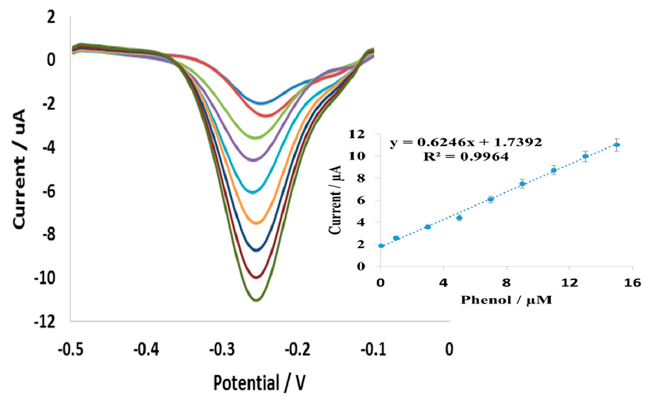
Figure 7. DPV obtained with the SPCE/Gr-Au-Chit/Tyr in 0.1 M PBS (pH 7.0) containing different concentrations of phenol from 0.05 μ M to 15 μ M. Inset is the calibration curve for the different concentrations of phenol in PBS. DPV = Differential pulse voltammetry.